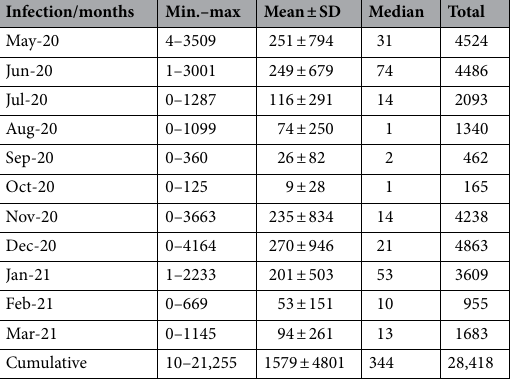
Table 1. COVID-19 infection rate in Sudan.